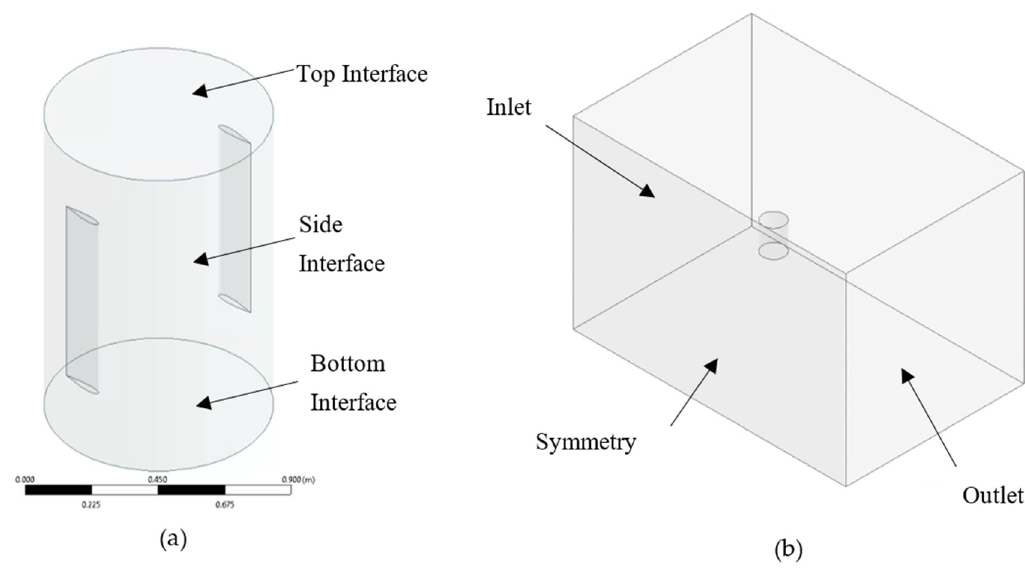
Figure 3. Sub-domains in current CFD simulation. ( a ) Rotor domain; ( b ) tunnel domain.